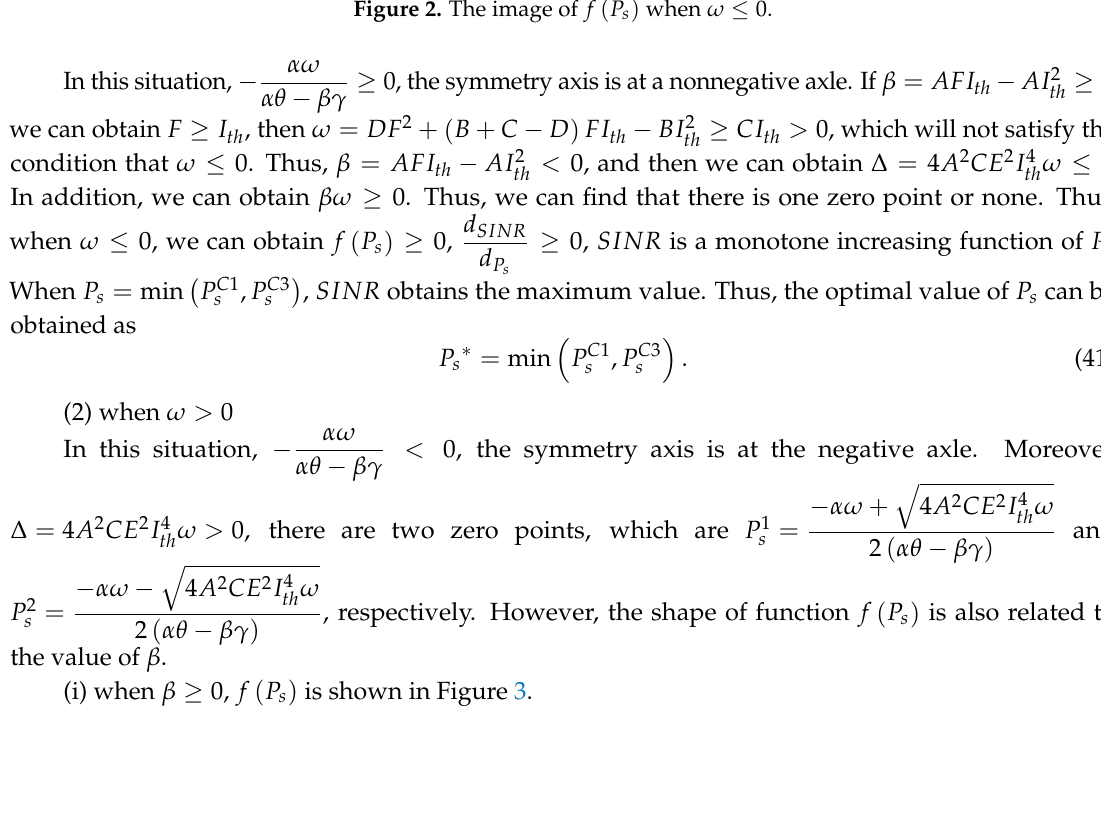
Figure 2. The image of f ( P s ) when ω ≤